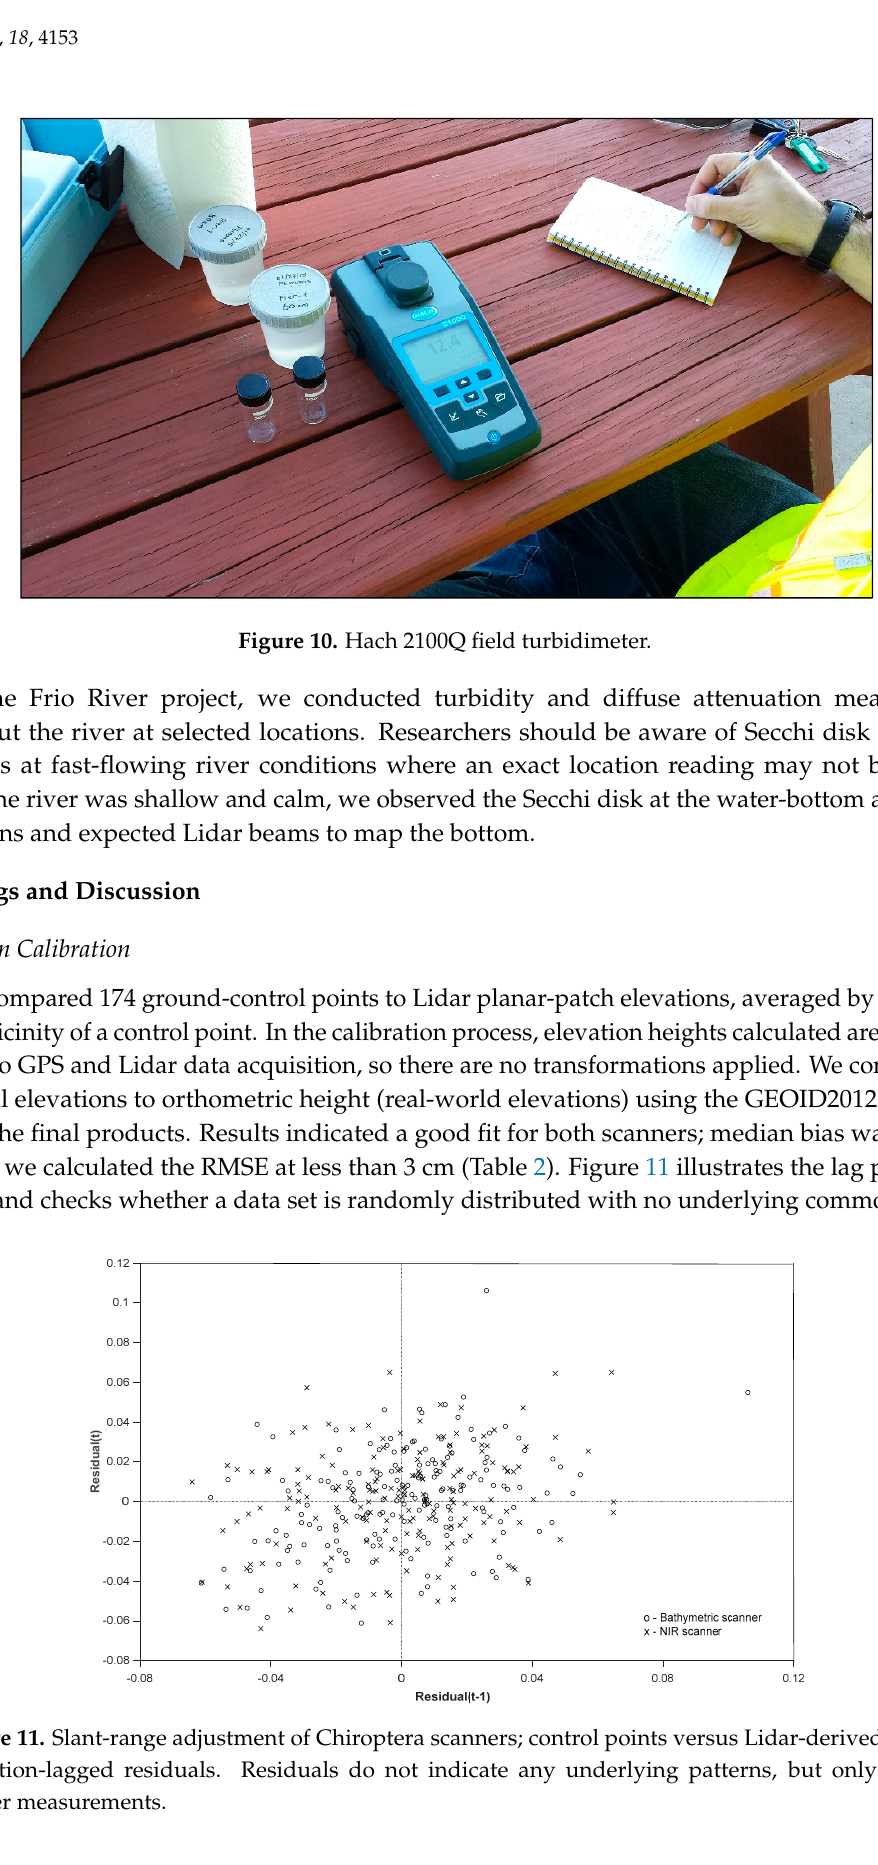
Figure 12. Garner State Park area, Texas, surface and elevation models of the Frio River and its surroundings. Table 2. Vertical-bias adjustment results after Chiroptera system calibration. Lidar Scanner